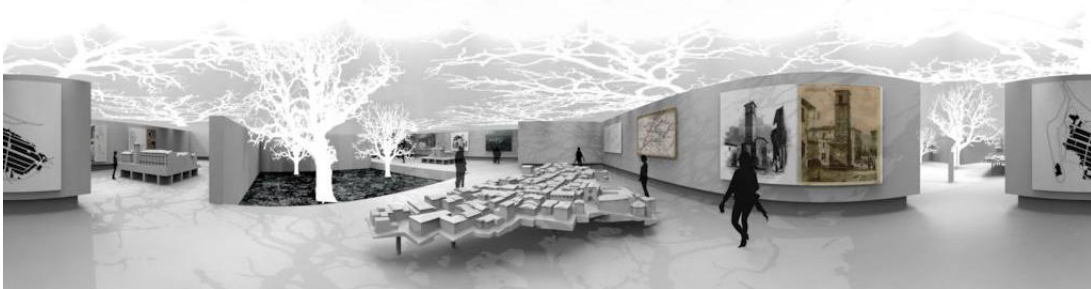
Figure 6. Part of an equi-retangular image for the representation of MUVAT space. The immersive experience is made possible by the use of spherical